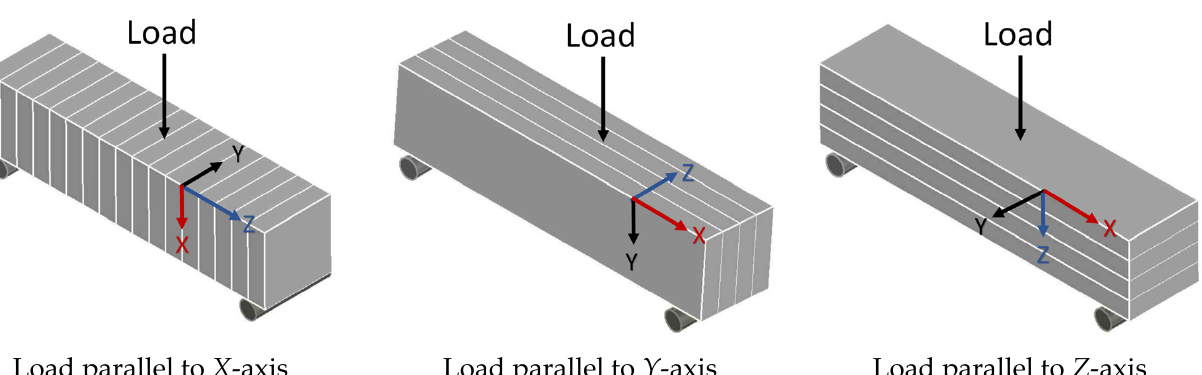
Figure 9. Designation of X , Y , and Z axes for the measurement of the anisotropy in flexural strength of printed concrete.